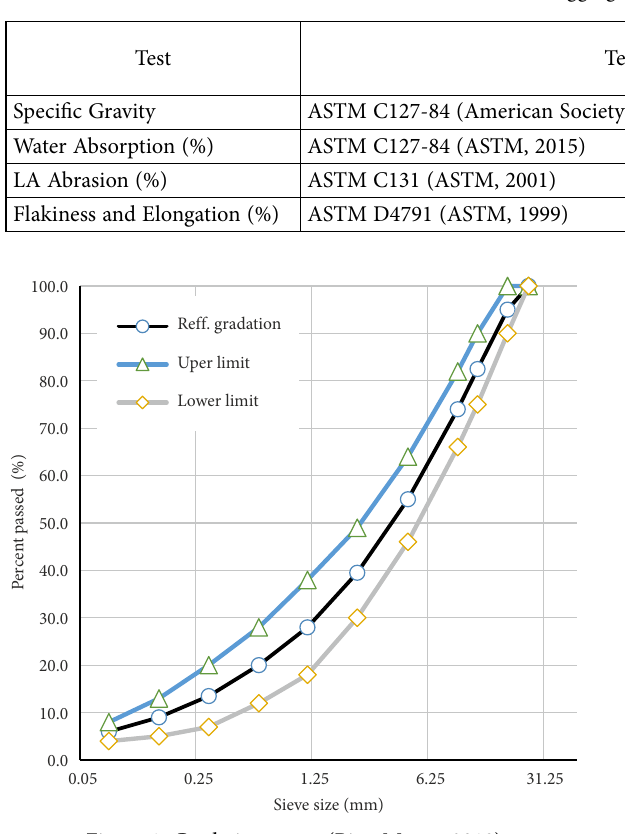
Figure 1. Gradation curve (Bina Marga, 2018)